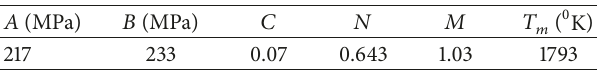
Table 5: Johnson-Cook constants of steel used in [2].